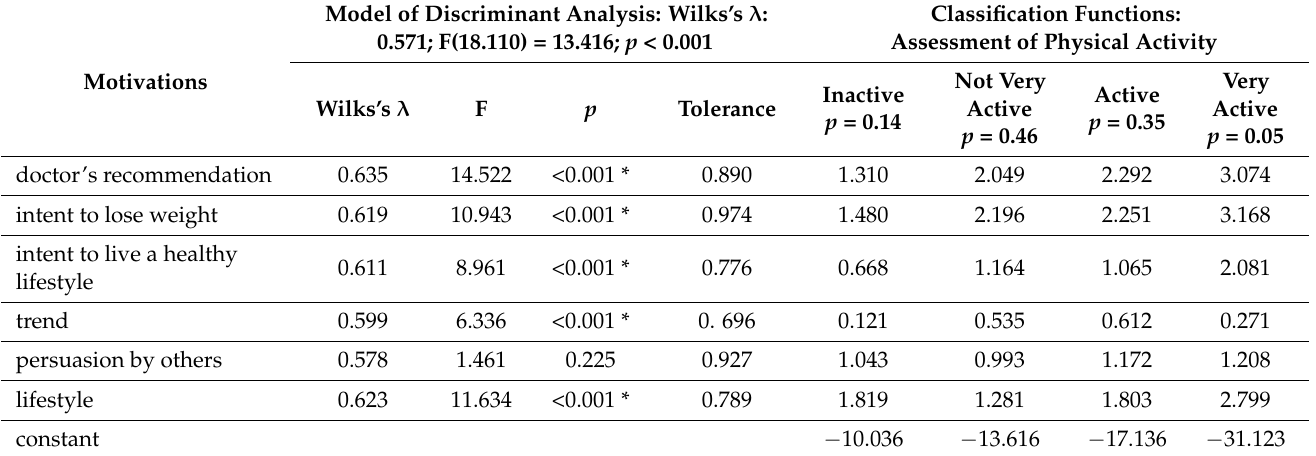
Table 8. Motivations for the use of healthy eating habits depending on the physical activity of young Poles—discriminant analysis.